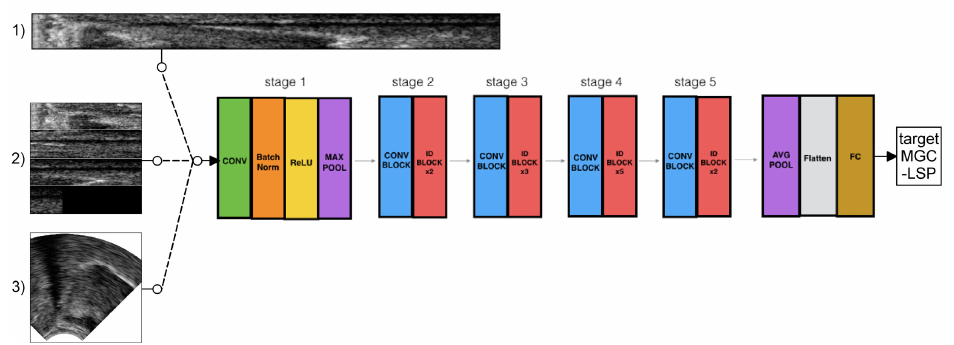
Figure 3. ResNet-50 architecture for articulatory-to-acoustic mapping using ultrasound tongue image (raw scanline vs. wedge) input and MGC-LSP target. ResNet image adopted from https: //towardsdatascience.com/understanding-and-coding-a-resnet-in-keras-446d7ff84d33,